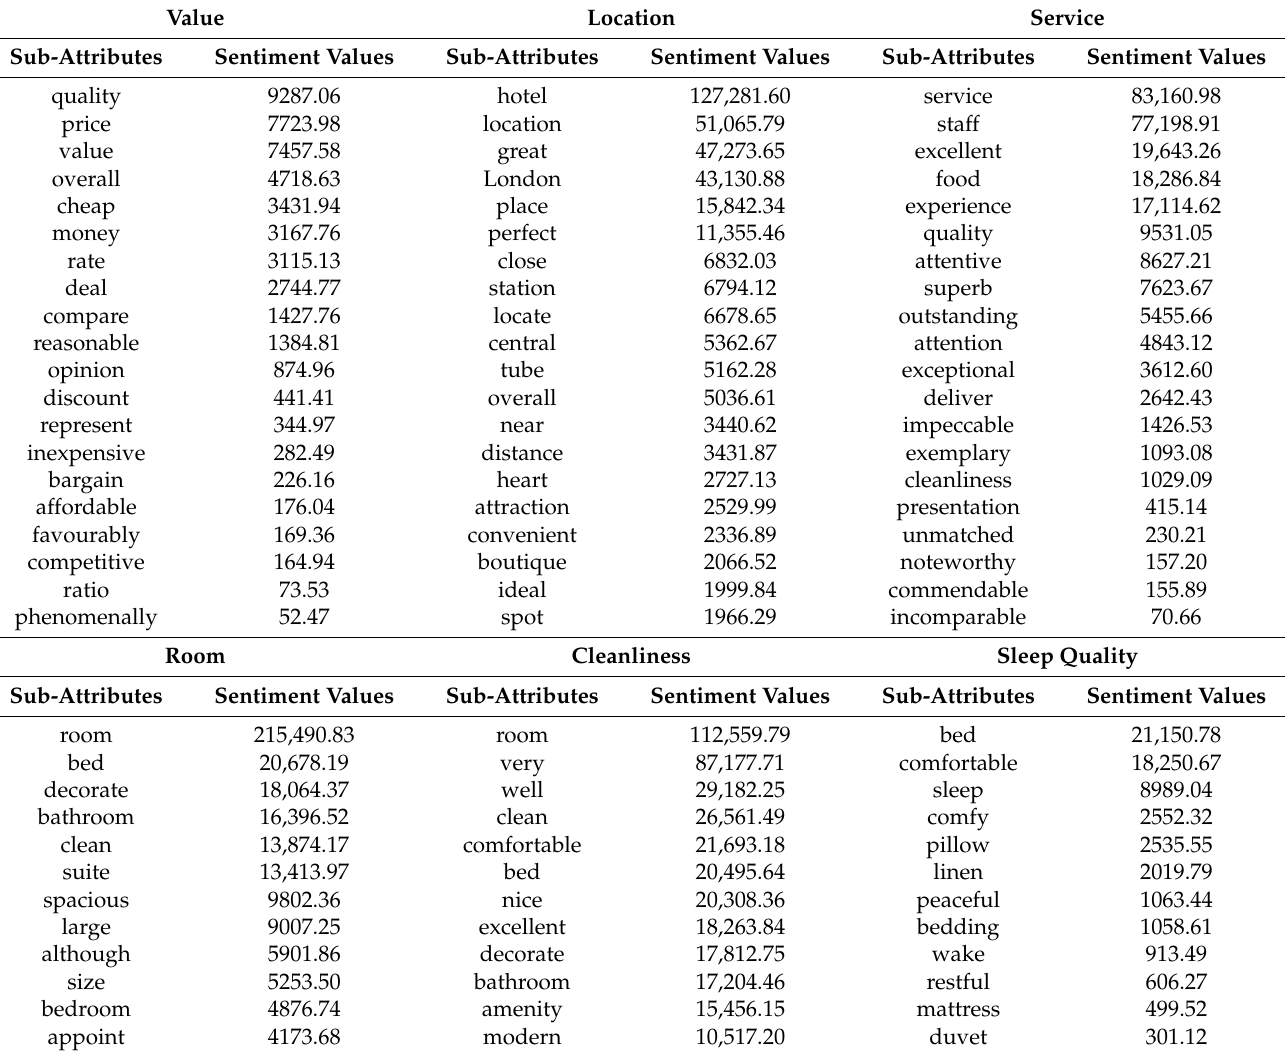
Table 7. Top 20 well-performed sub-attributes with the strongest positive sentiment polarity with respect to six attributes in five-star